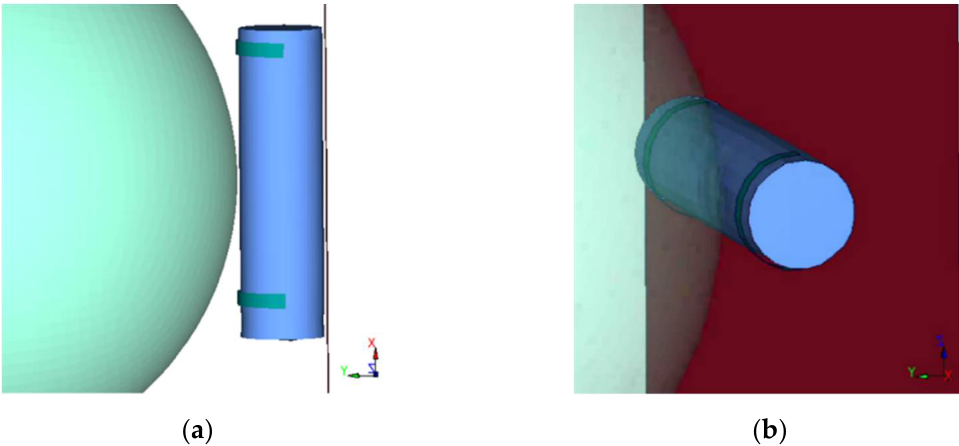
Figure 13. Simulation of the battery: ( a ) layout side view of the initial state and ( b ) last state of the simulation.